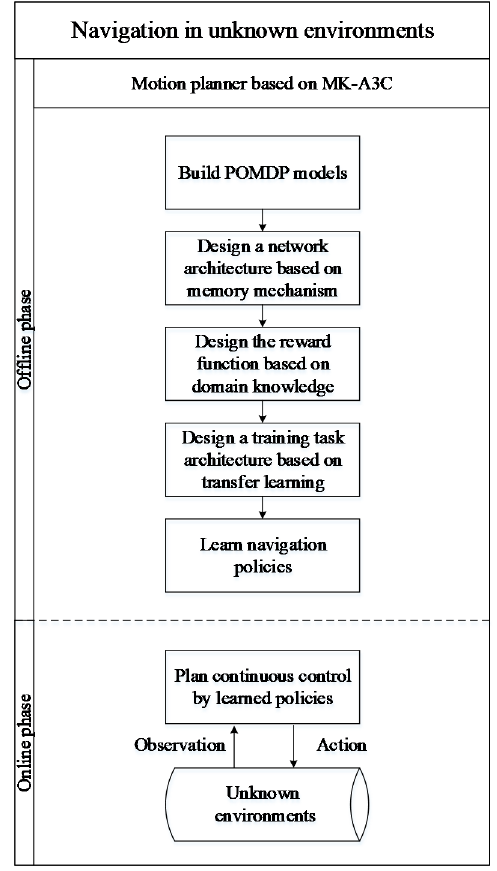
Figure 2. Flowchart of the MK-A3C method.